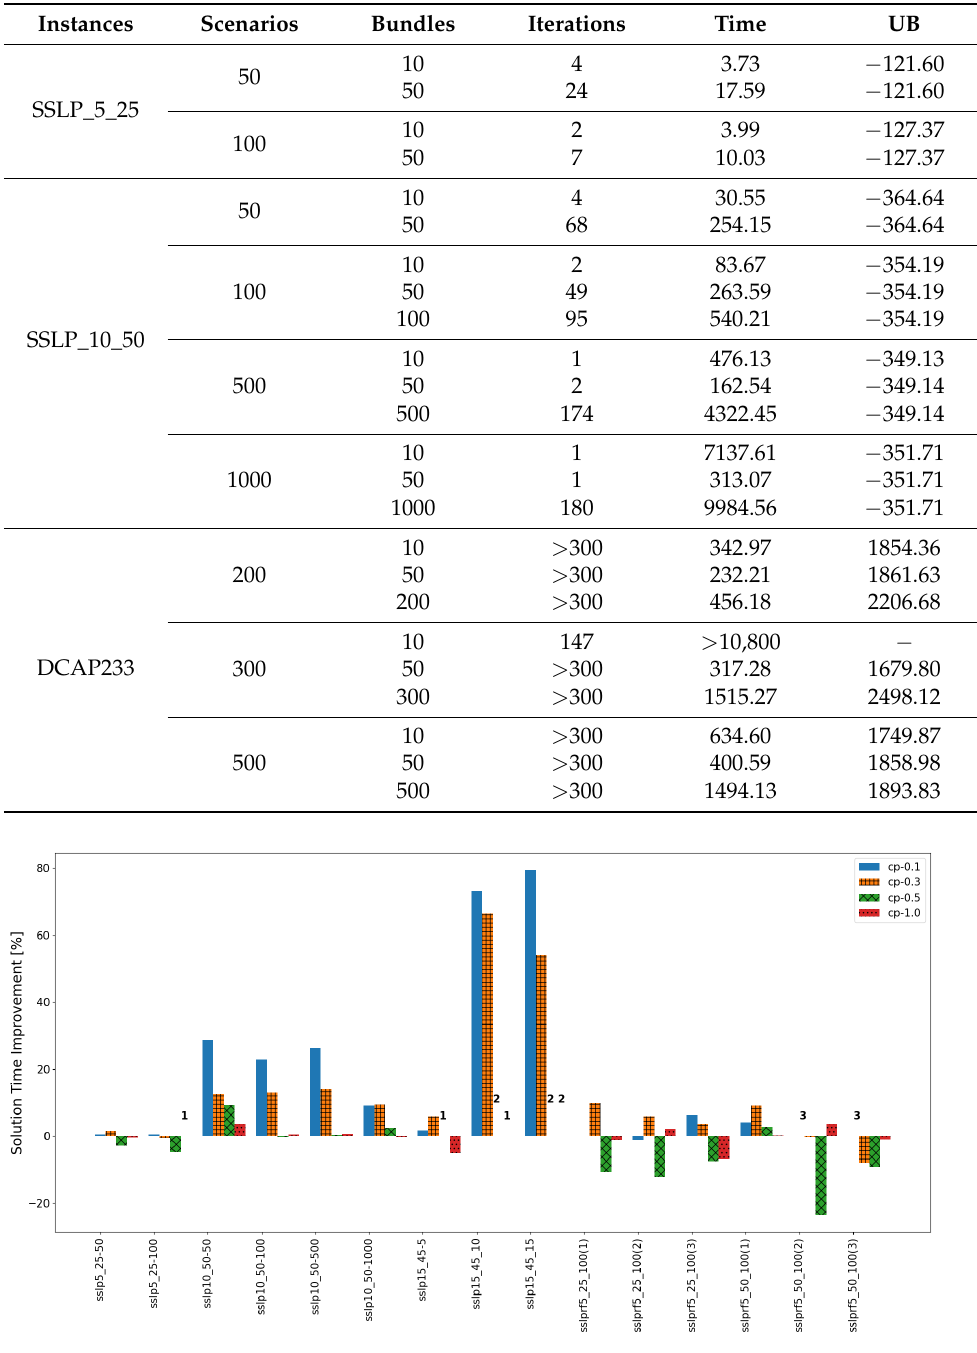
Figure 3. Solution time improvement by using WW heuristics for SSLP and SSLPR